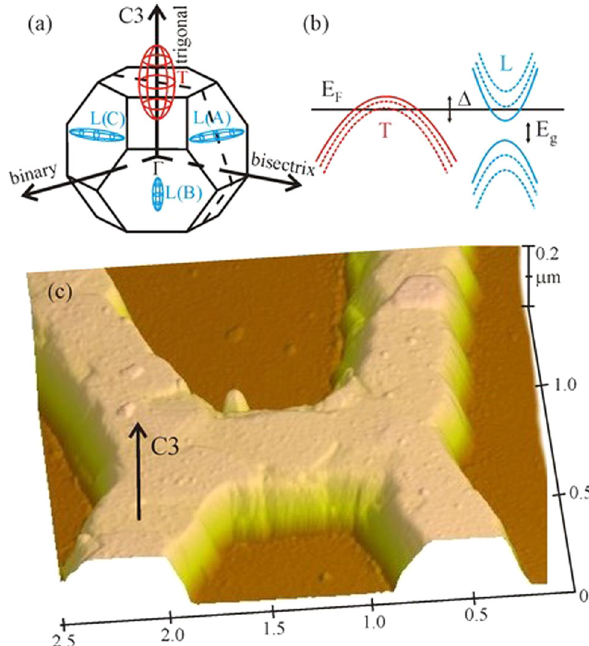
Fig. 1 Fermi surface, energy spectrum and typical nanostructure. a Fermi surface of bulk bismuth. Electron 'pockets' are presented by ellipsoids in three equivalent L-points of the Brillouin zone, holes are located in ellipsoid in T-point. b Schematic representation of the energy spectrum of bismuth. Solid lines correspond to bulk sample, while the dashed lines stand for energy quantization due to quantum size effect. c AFM image of typical structure before ion milling. One can clearly distinguish the single crystalline texture. Trigonal axis C3 is normal to the sample plane